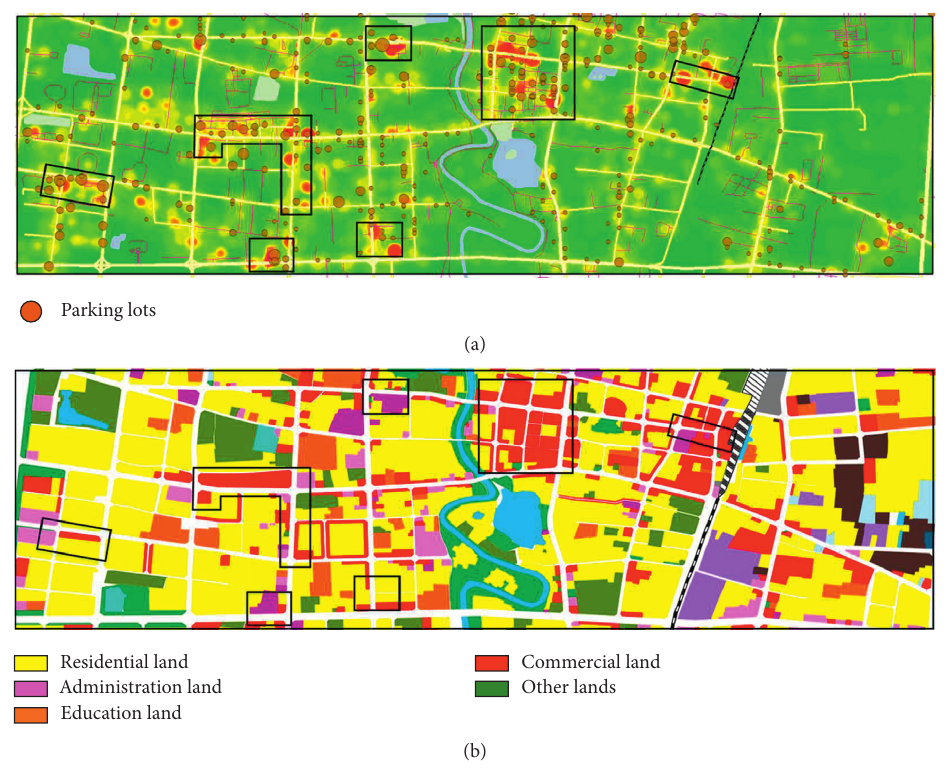
Figure 2: (a) Origin-destination kernel density distribution coupled with parking resource allocation. (b) Distribution of land